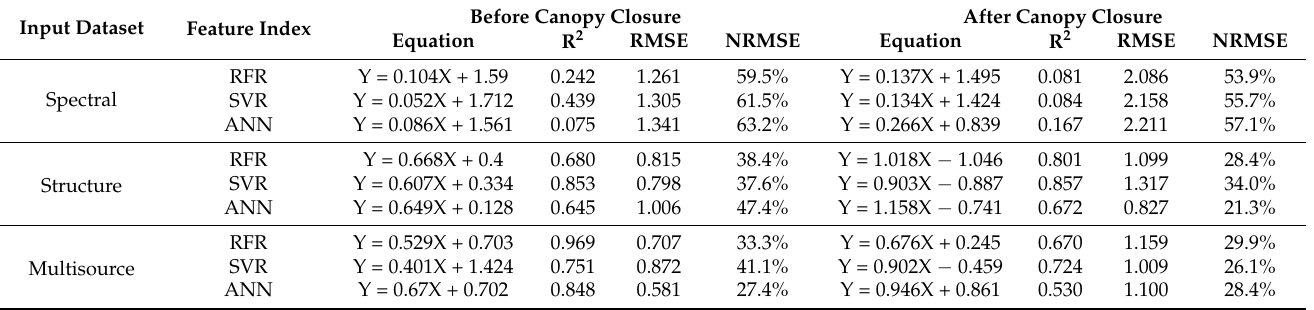
Table 7. Quantitative relationship between the LAI and measured values based on machine learning models before and after canopy closure in the test dataset (experiments B and